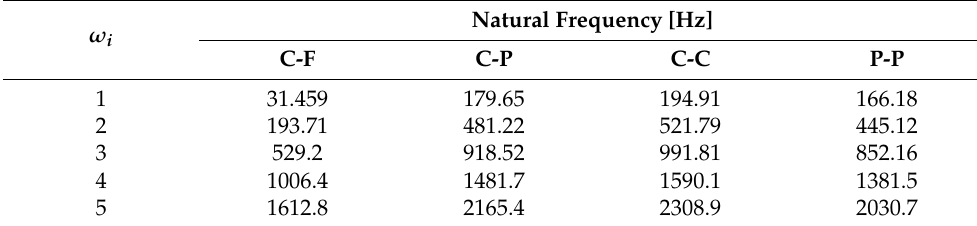
Table 2. First five natural frequencies of a symmetric three-layered beam with the different end conditions. Natural Frequency ω i